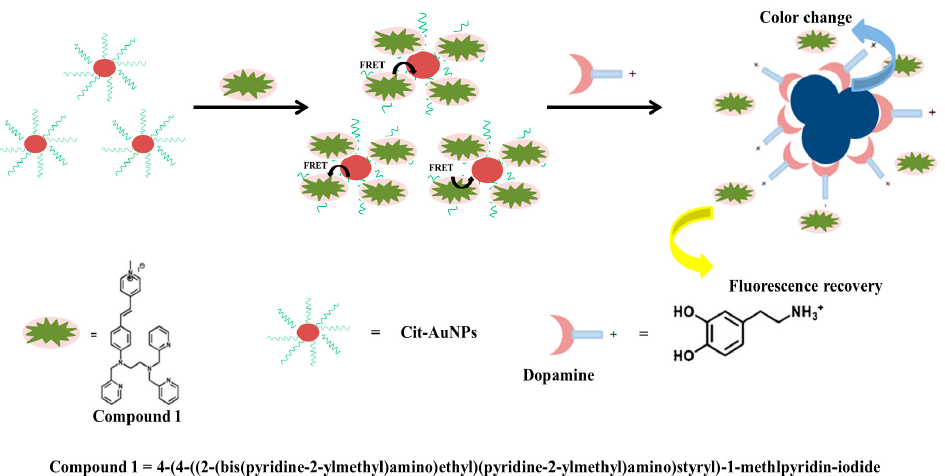
Figure 6. Schematic illustration of a novel nanoprobe containing AuNP fluorophore for detection of DA. Adapted from Ref. [63].